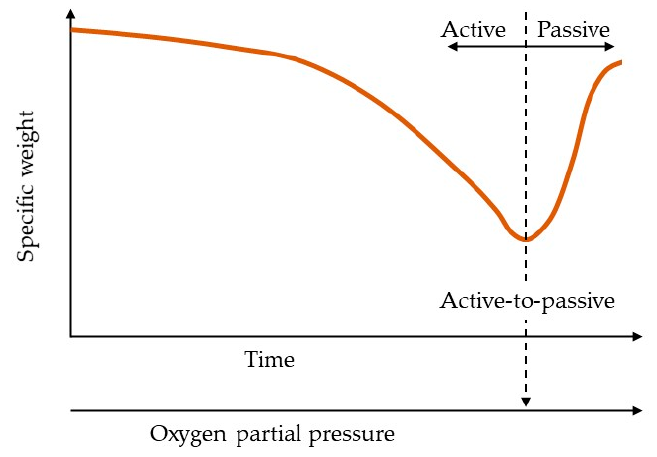
Figure 1. Schematic diagram on weight change during active and passive oxidations of SiC according to oxygen partial pressure (drawn by the authors referring to data reported by Jacobson [39]).